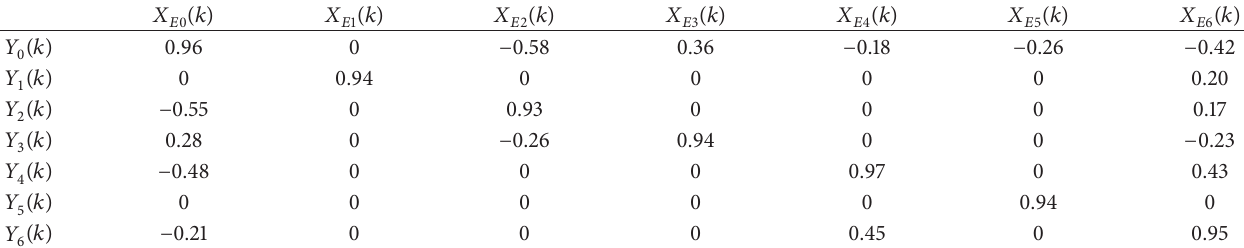
of the sensitivity of emotional status. OM